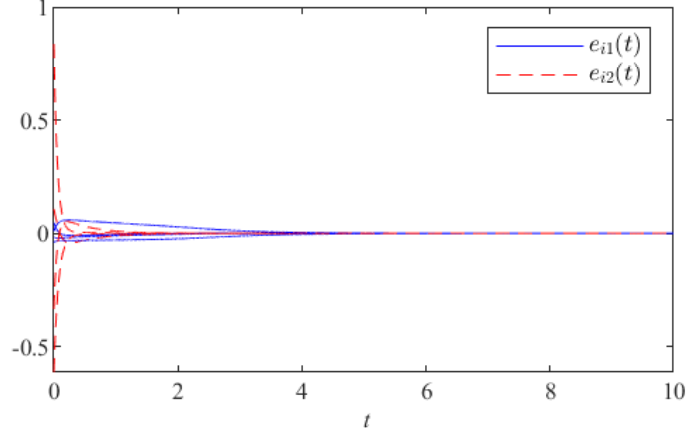
Figure 2. The system error e i ( t ) of MAS with boundary coupling (4) in Example 1.